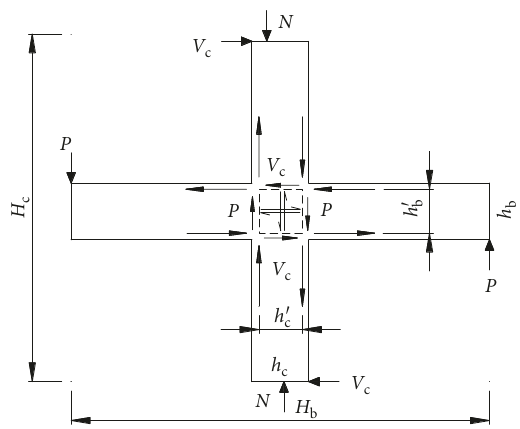
Figure 5: Free body diagram of the interior